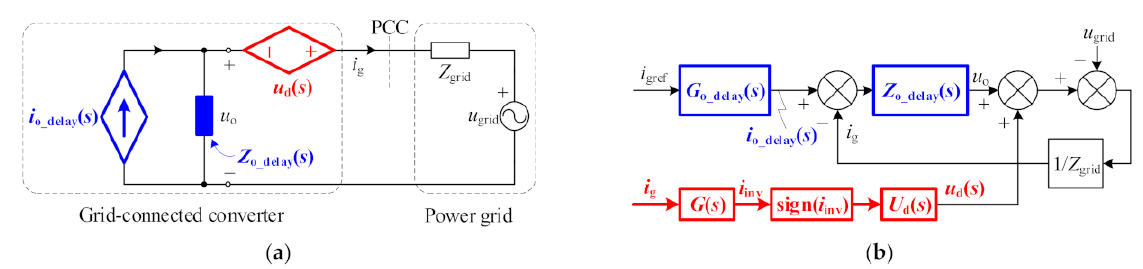
Figure 8. The equivalent impedance model considering dead-time delay effects and digital control delay: ( a ) Norton equivalent circuits; ( b ) Output-impedance